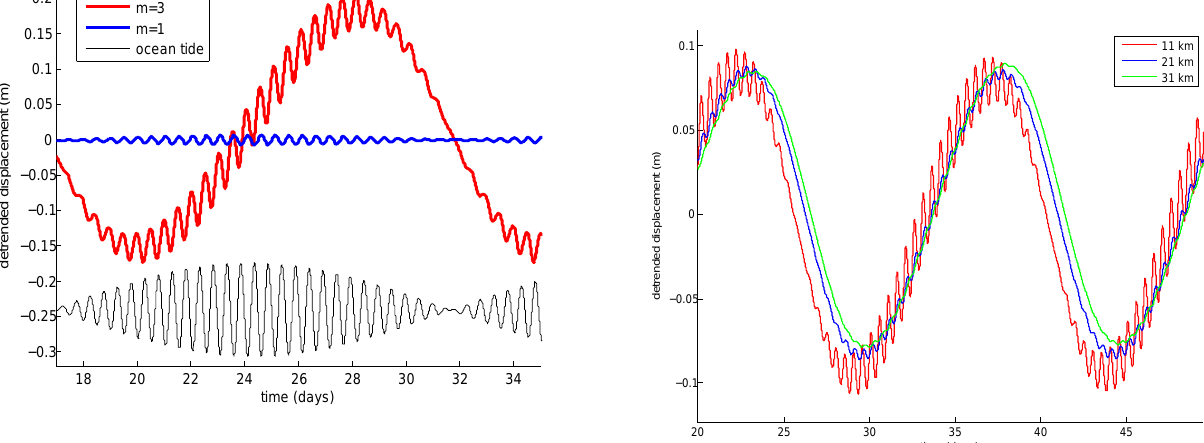
Fig. 4. The effects the stress exponent m on modelled ice-stream response to tides. Linearly-detrended surface displacements 11km upstream from the grounding line are shown for m = 3 (red curve) and m = 1 (blue curve). In the figure the ocean tide used to force the model is shown as a black curve (scaled down by a factor of 60 and shifted for visualisation purposes).